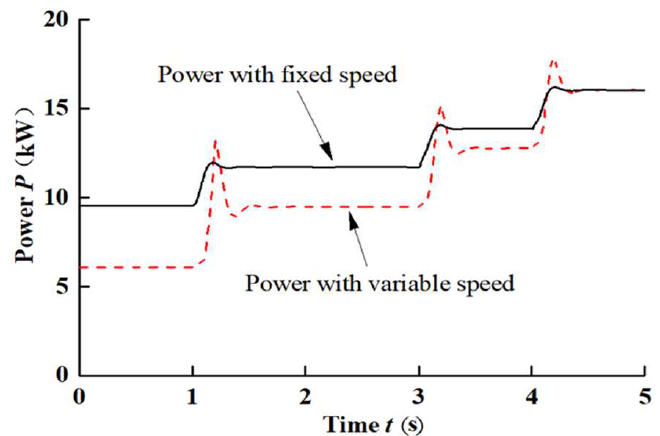
consumption is about 6.1 kW with variable-speed control, while it is about 9.5 kW with fixed-speed control.